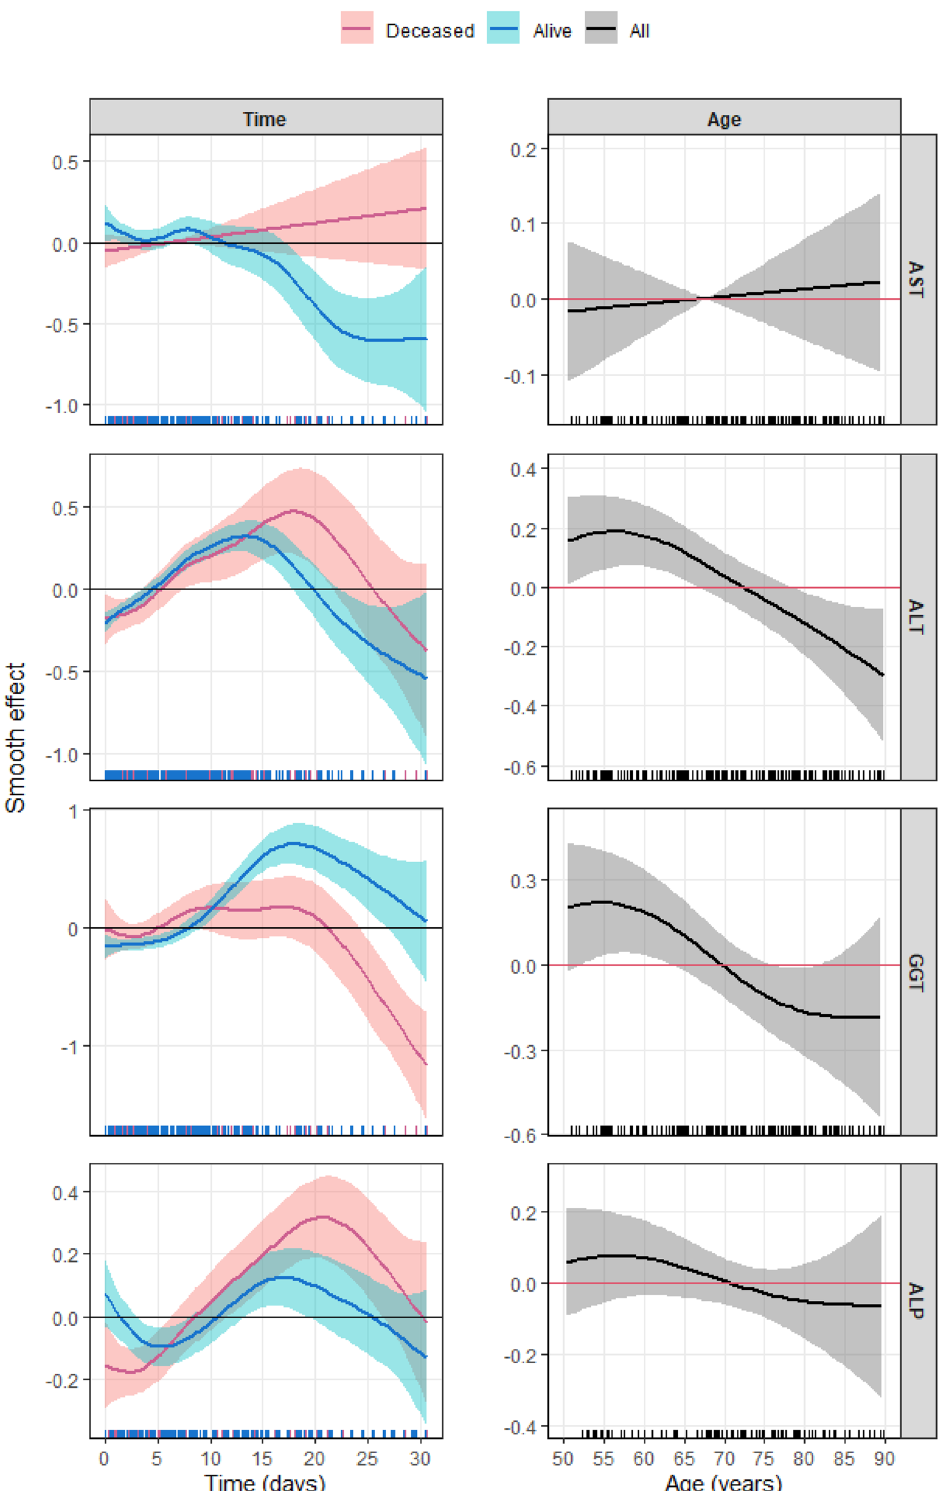
Figure 2. Estimated centered smooth effect (with 95% CI) of time (left) and age (right) over the weighted and Box–Cox-transformed transaminases extracted from the generalized additive multivariate models in Table 3. Pink stands for deceased patients, blue for the living, and black for the total number of patients. The horizontal line indicates zero, and when it lies inside the 95% CI, no statistical significance was